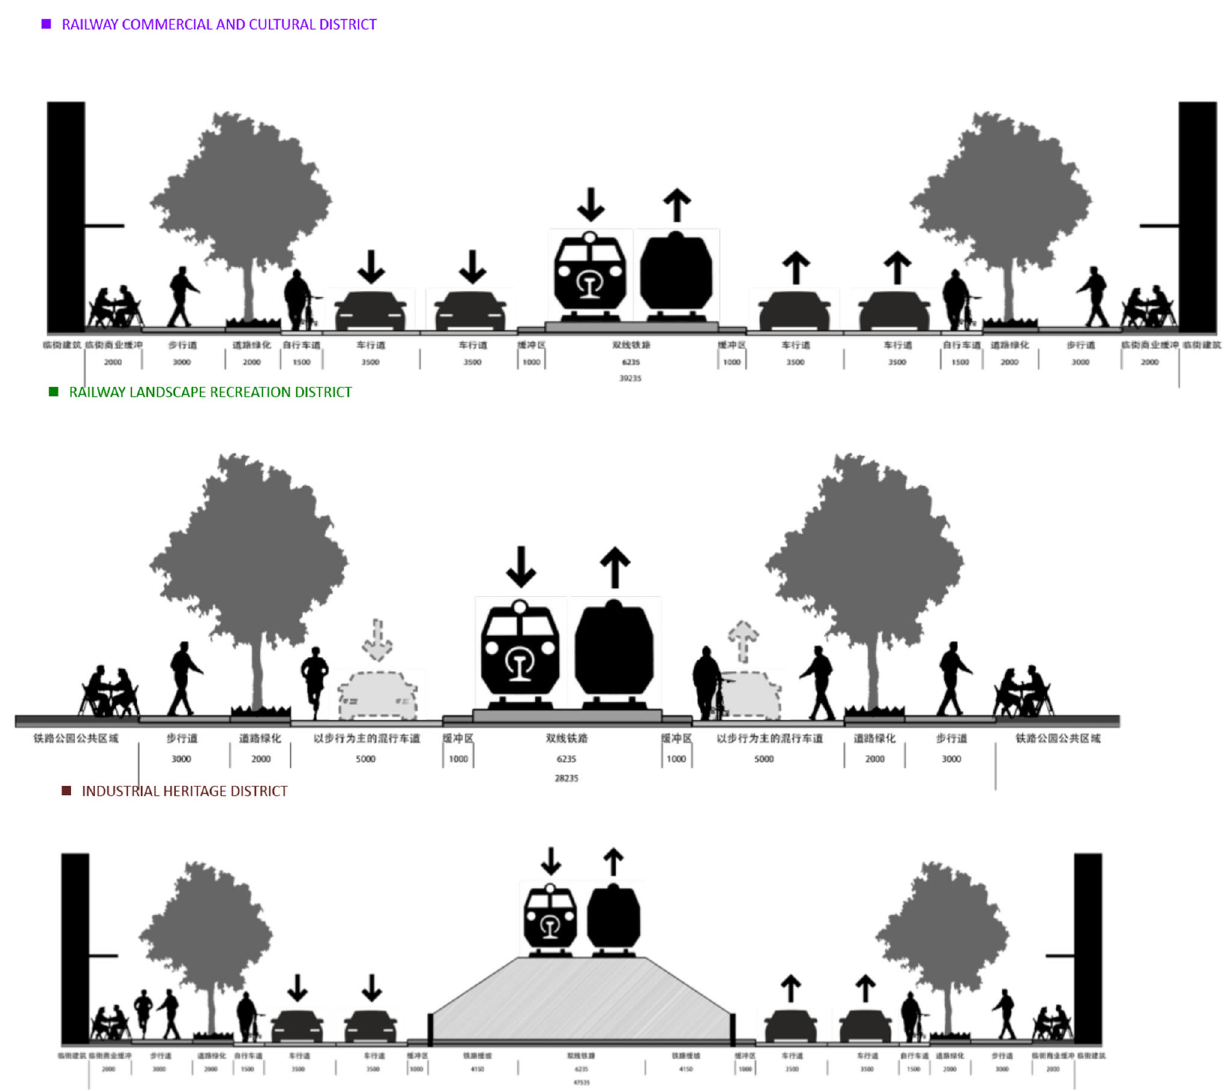
Fig. 8 Redesign of the roads along the railway. Source : Drawn by the